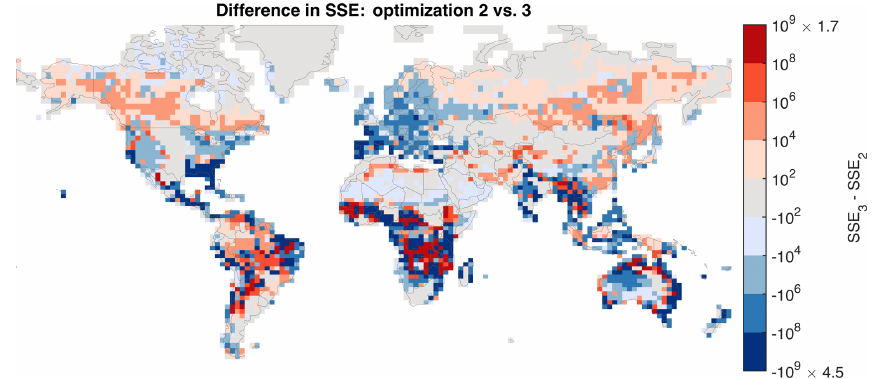
Figure 9. Difference in non-agricultural fire model burned area sum of monthly squared errors (SSE) between Optimizations 2 and 3. Blue represents areas where the latter performs